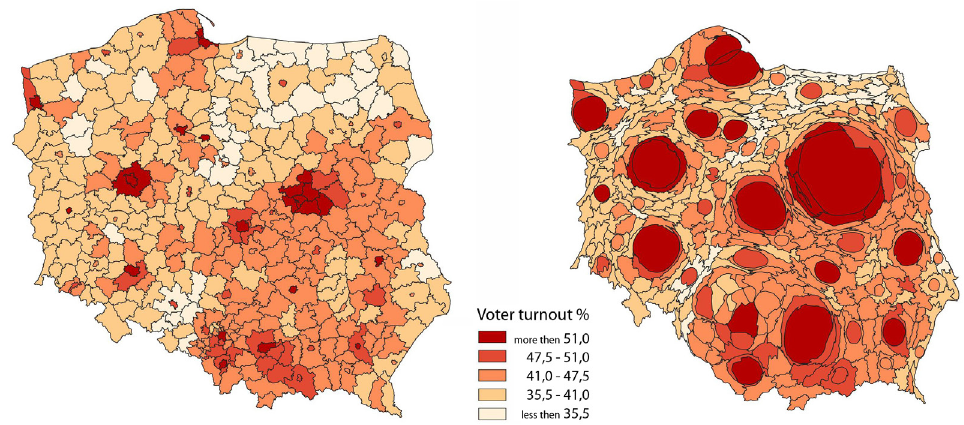
Fig. 2. Maps a model: left – Aristotelean idealisation (simple choropleth map); right – Galilean idealisation (anamorphic cartograms). European Parliament elections in 2019. Voter turnout (Markowska,